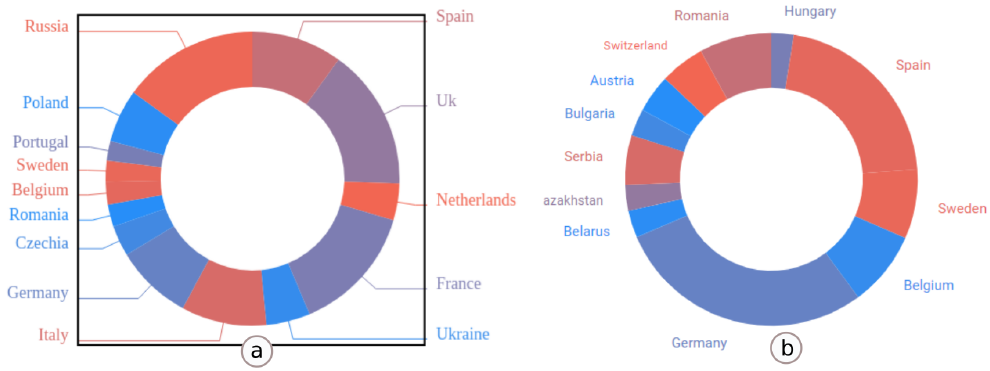
Figure 5. A 3: ( a ) A 3 L list arrangement example; ( b ) A 3 Ln linear arrangement